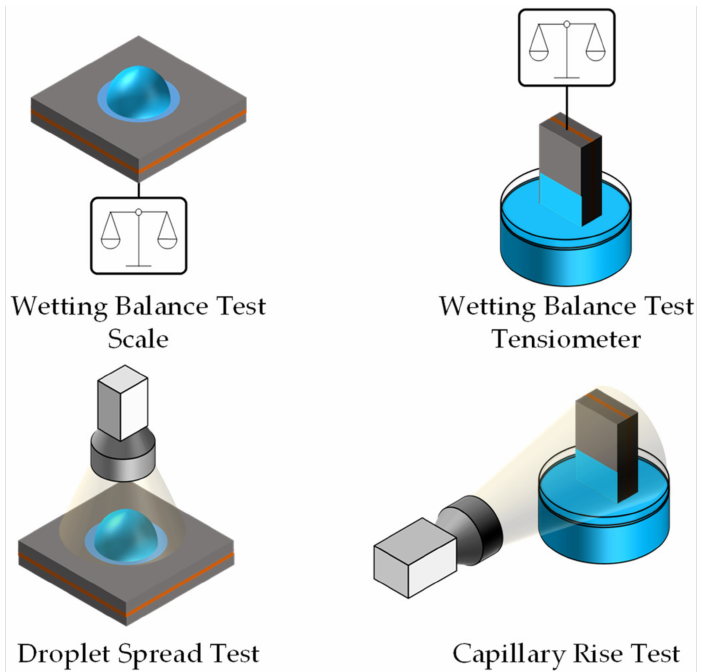
Figure 3. Schematic illustration of the common measurement methods used to measure the wetting properties of cell composite